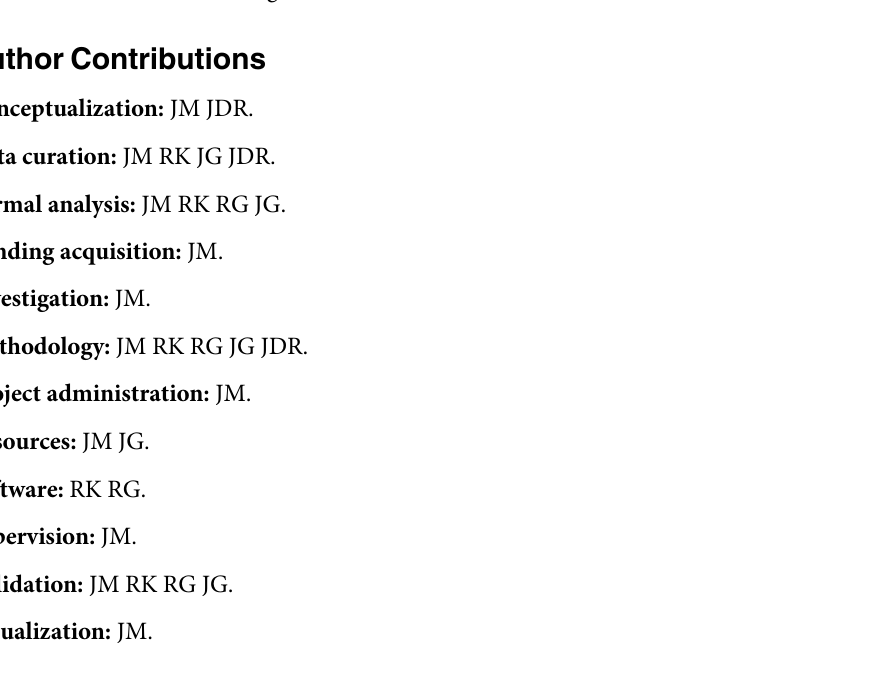
S1 Table. Multivariable conditional logistic regression of risk factors for endometrial can- cer, excluding premenopausal women from the analysis. S2 Table. Multivariable conditional logistic regression of risk factors for endometrial can- cer, including weight at least 50 pounds above ideal weight in the model. S3 Table. Multivariable conditional logistic regression of risk factors for endometrial can- cer, excluding current smoking status from model. S4 Table. Multivariable conditional logistic regression of risk factors for endometrial can- cer, including age at menarche and number of live births. S5 Table. Multivariable conditional logistic regression of risk factors for endometrial can- cer, including unadjusted cadmium concentration and creatinine